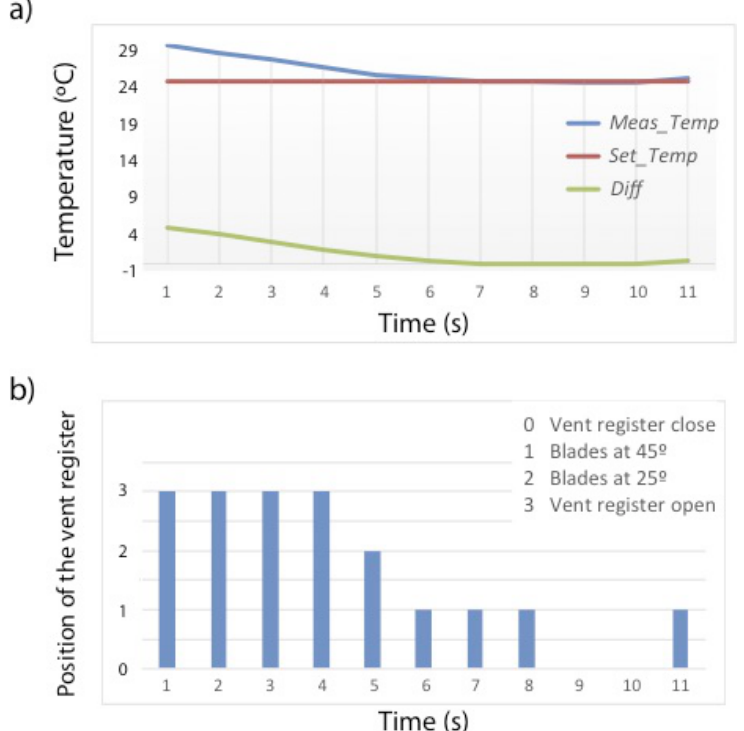
Figure 14. Example of the algorithm performance in the summer season for Zone 1. ( a ) Variation of the current temperature (blue line) together with the configured one (red line) and the air flow demand (green line). ( b ) Opening level of the blades according to the flow demand.